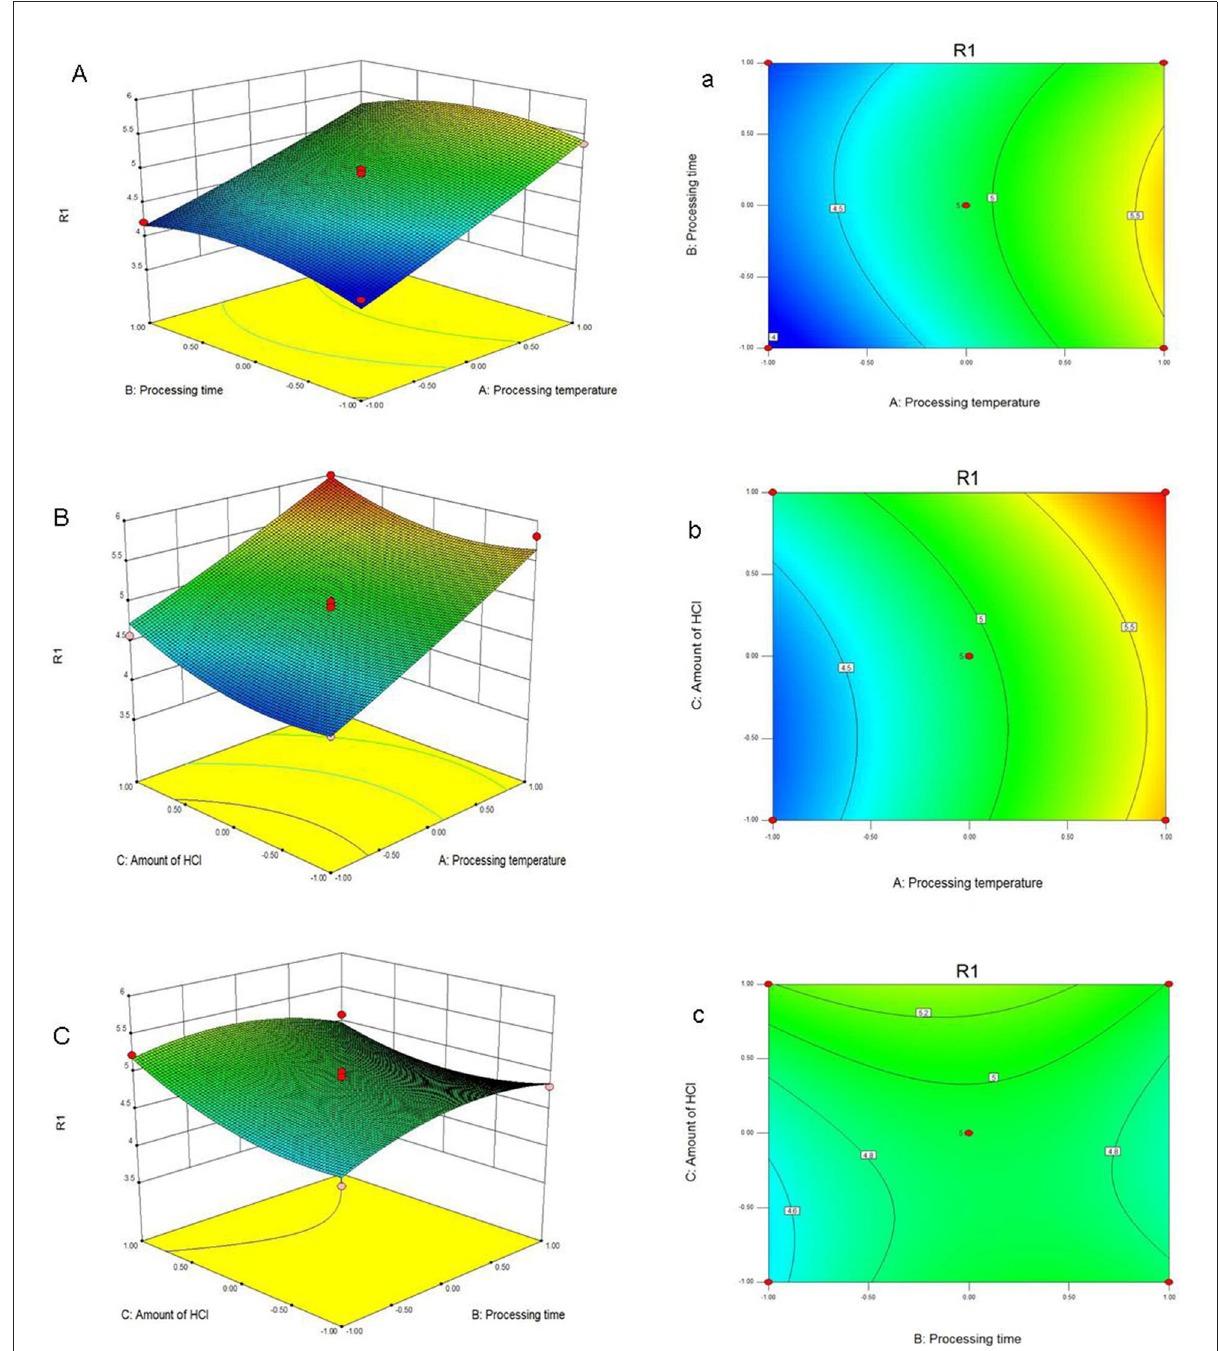
FIGURE1 Response surface plots (A–C) and contour plots (a–c) showing the effects of processing temperature, processing time, amount of HCl and their mutual effects on the extraction yield of PFSV (R1).